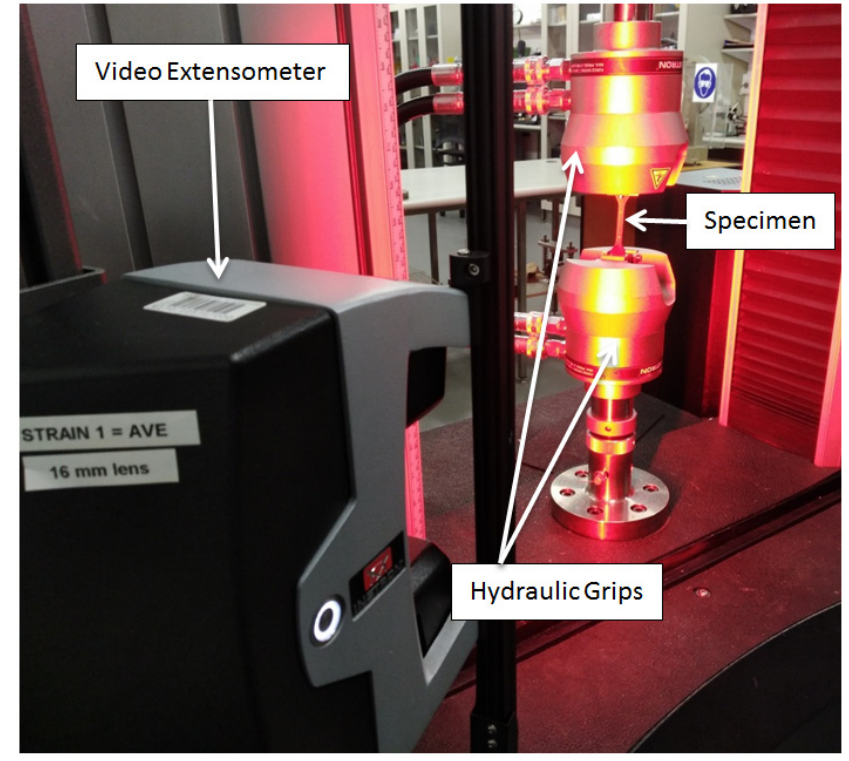
Figure 3. Tensile Testing of Specimens using INSTRON Universal Testing Machine .